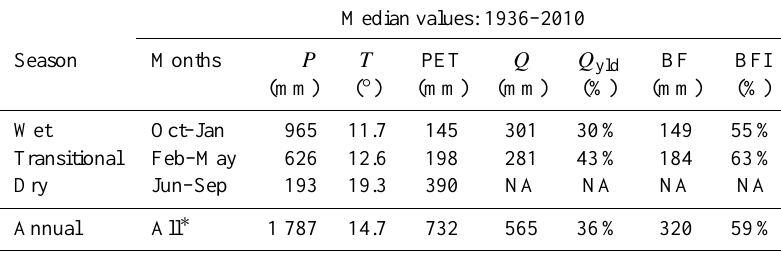
Table 3. Seasonal and annual median values of the hydrometeorological variables in Águeda watershed from 1936 to 2010.